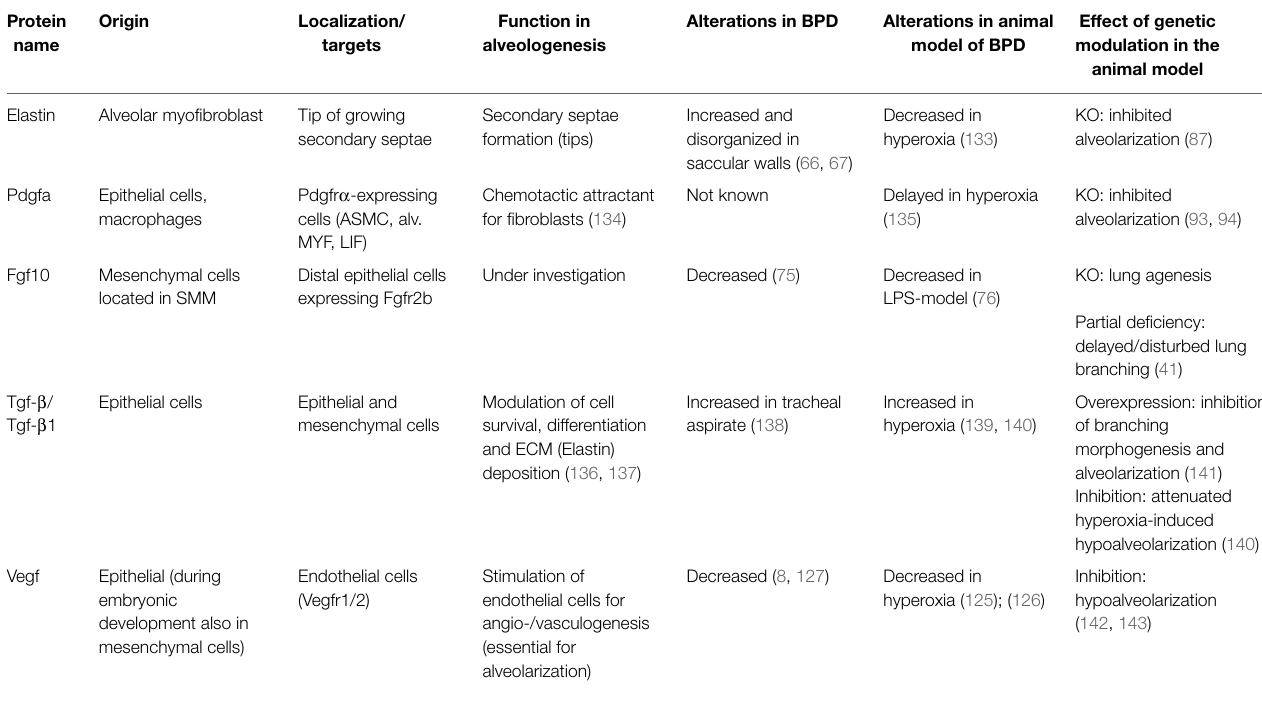
TABLE 1 | Overview of proteins that are known to be involved in alveologenesis